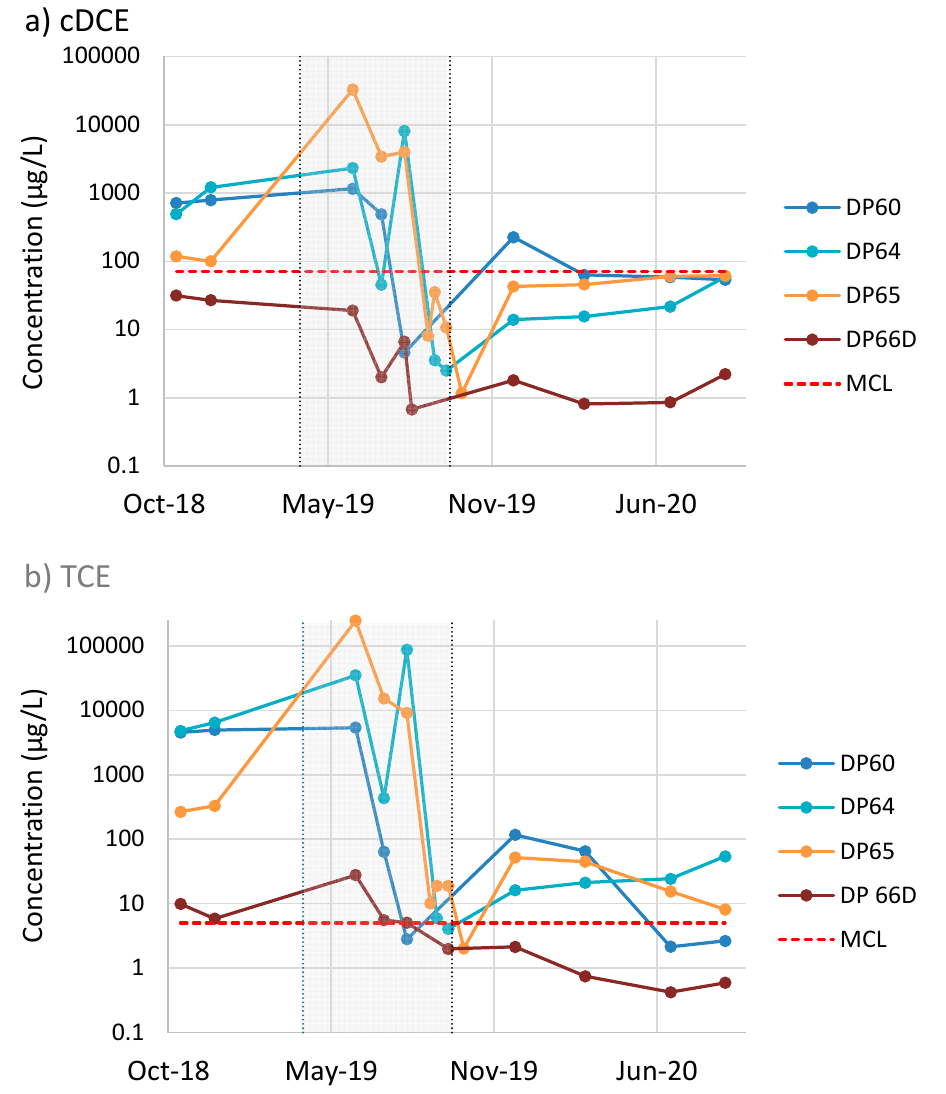
Figure 9. Concentrations of ( a ) cDCE and ( b ) TCE in selected groundwater monitoring wells located in the ERH Treatment Zone at the Brandywine DRMO Yard. The ERH thermal treatment system operated from April to October 2019 (gray area). The red dotted line indicates the MCL of the respective compound. Data from HGL